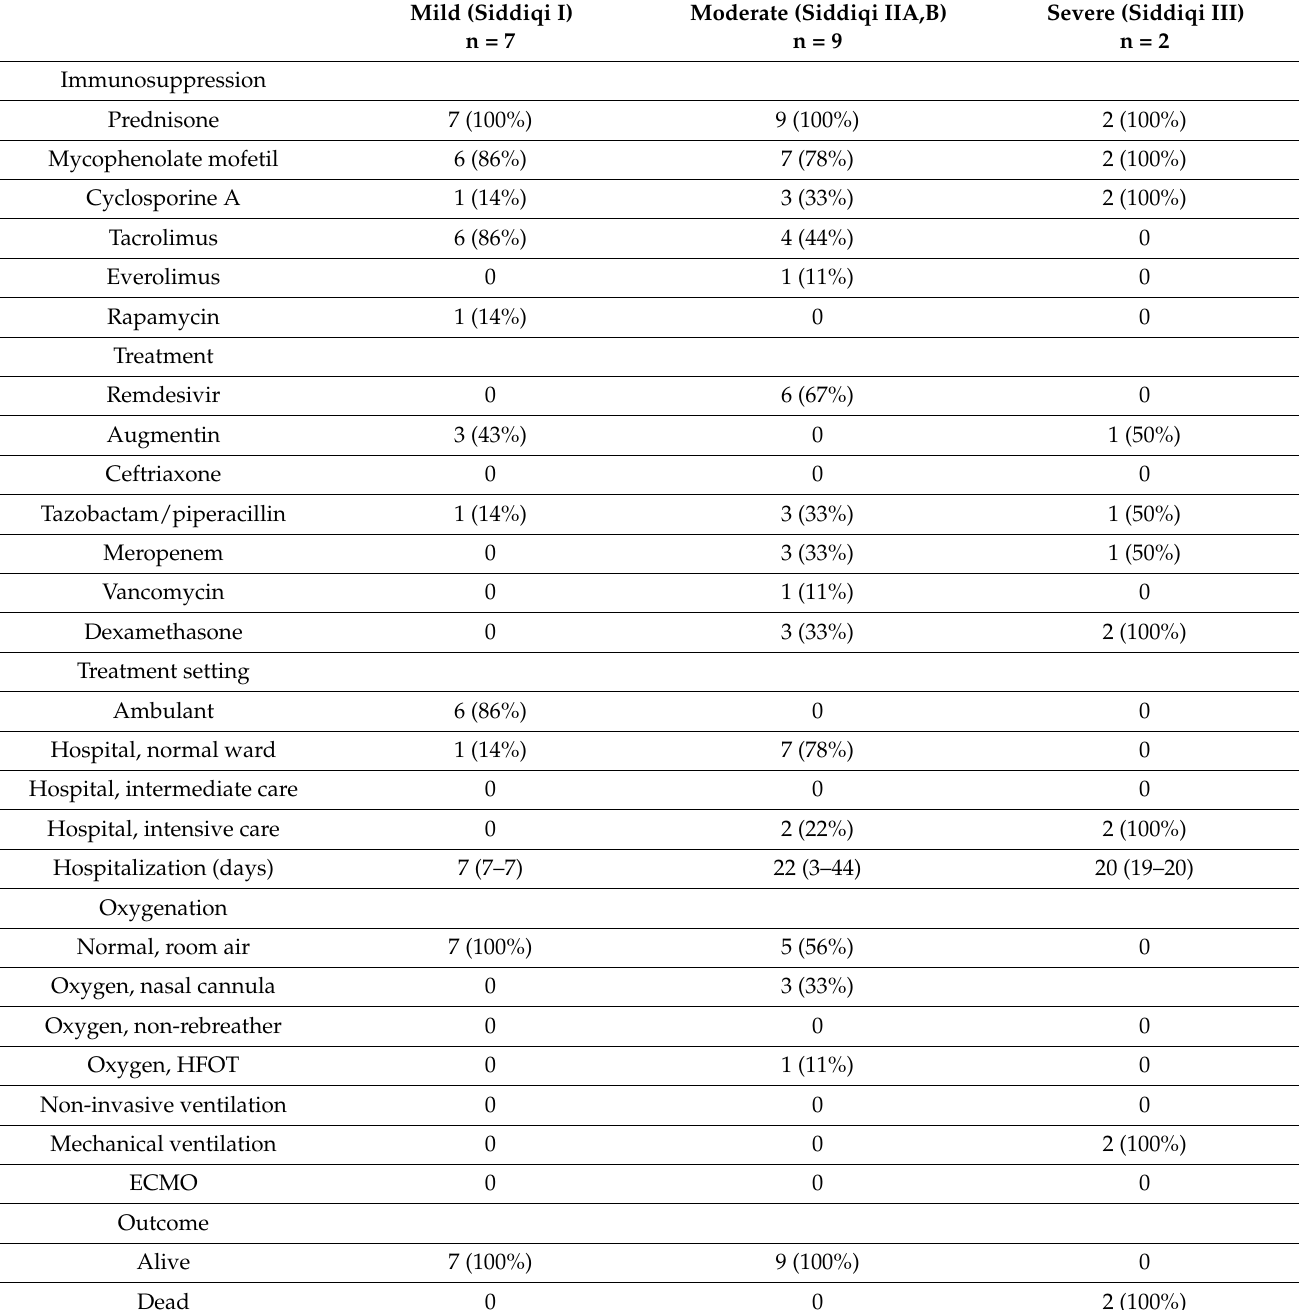
Table 3. Treatment strategies.